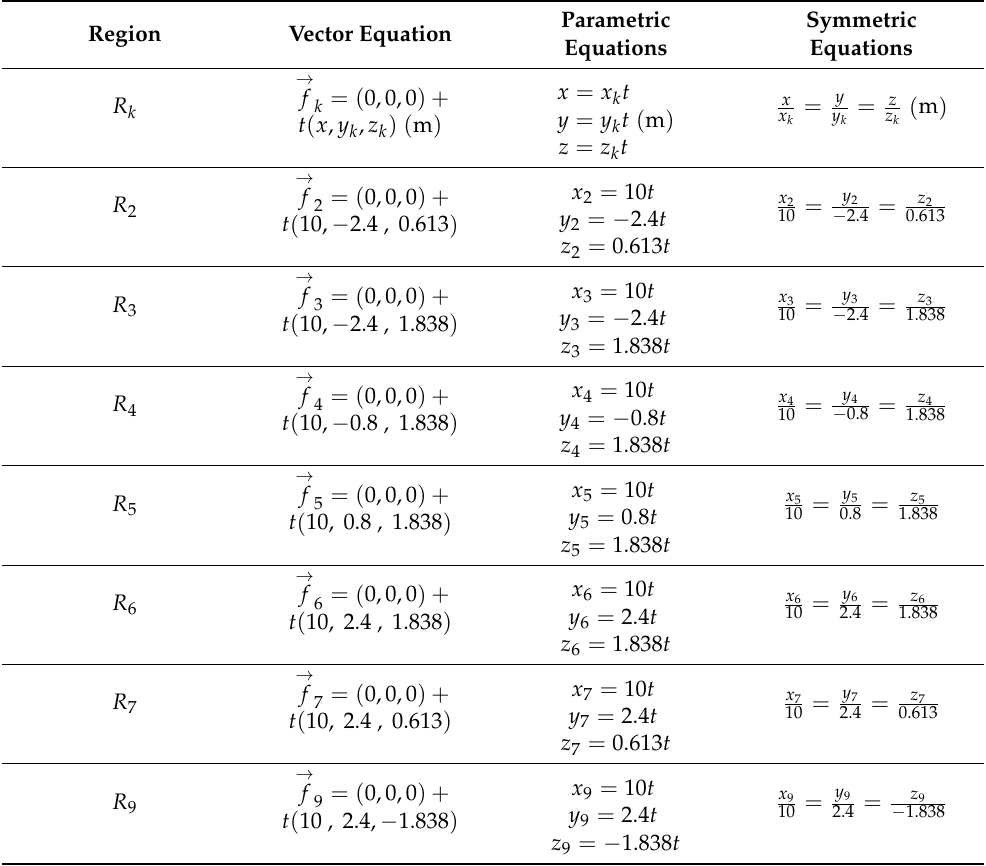
Figure 10. Third experiment. ( a ) Frame used in the third experiment: the object is in the regions 𝑅 2−7 , and 𝑅 9−13 identified with a red circle and 𝑅 1 collision − free regions and are identified 𝑅 8 with a blue circle; ( b ) graphical representation of vector reference 𝒇⃗ 𝟏𝟐 .